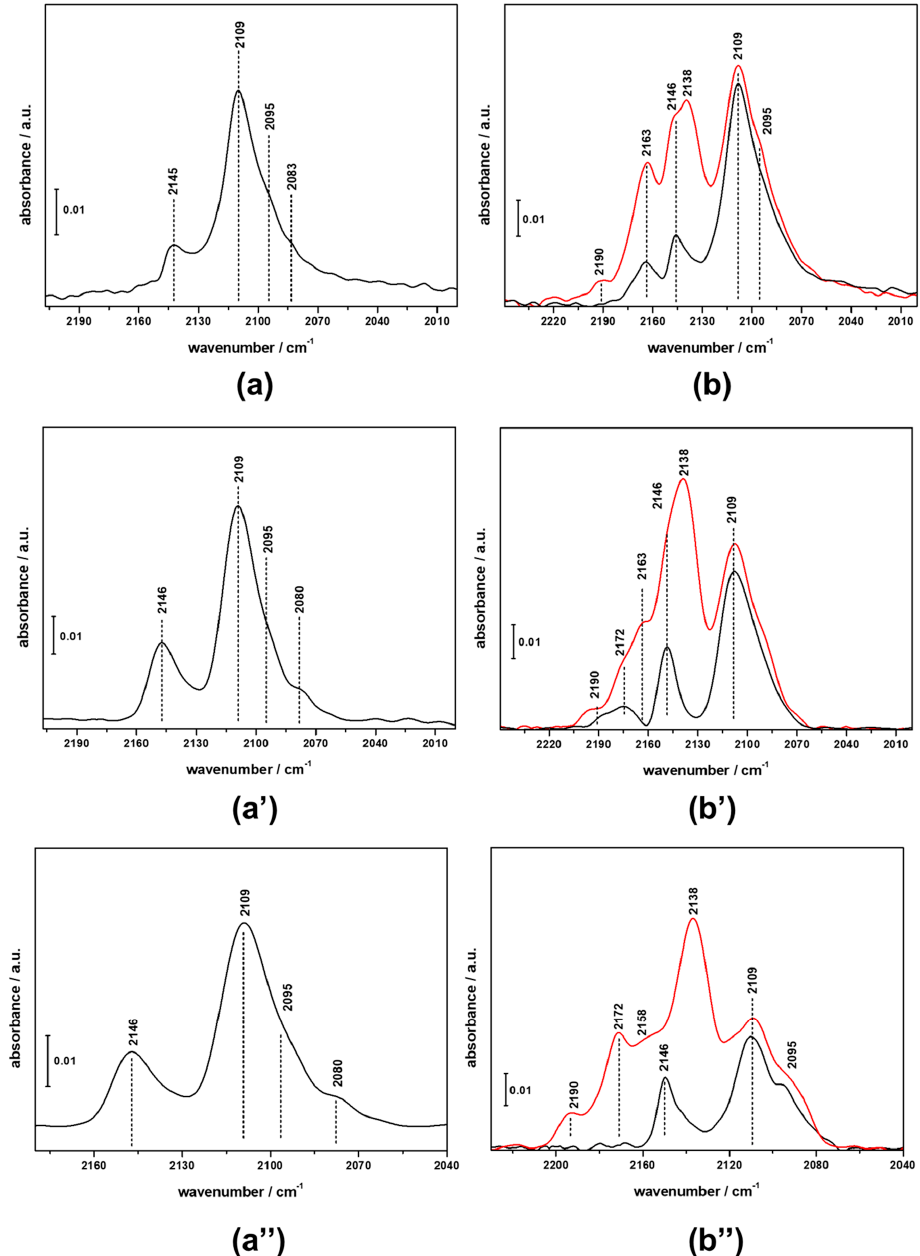
Figure 4. FTIR difference spectra of CO adsorbed on CZZFER catalysts at room temperature (sections a , a’ and a” ) and at LN temperature (sections b , b’ and b” ), at maximum coverage (red spectra) and after outgassing until the disappearance of the CO liquid-like signal at 2138 cm − 1 . (sections a and b refer to CZZFER8; sections a’ and b’ refer to CZZFER30; sections a” and b” refer to CZZFER60).